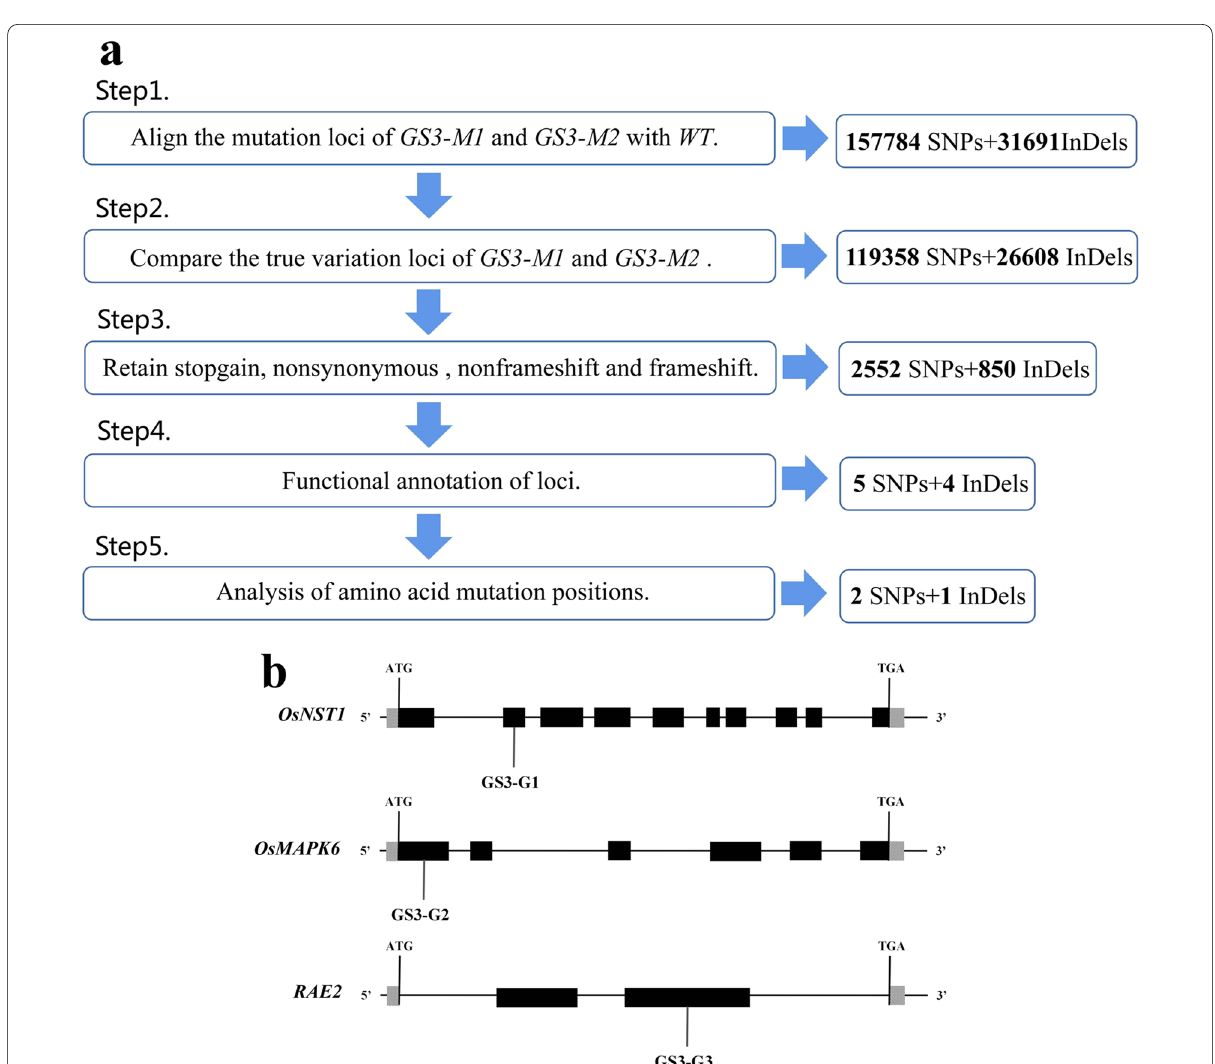
Fig. 7 a Whole-genome mutation screening process. b Positions of the three new SNPs on their corresponding